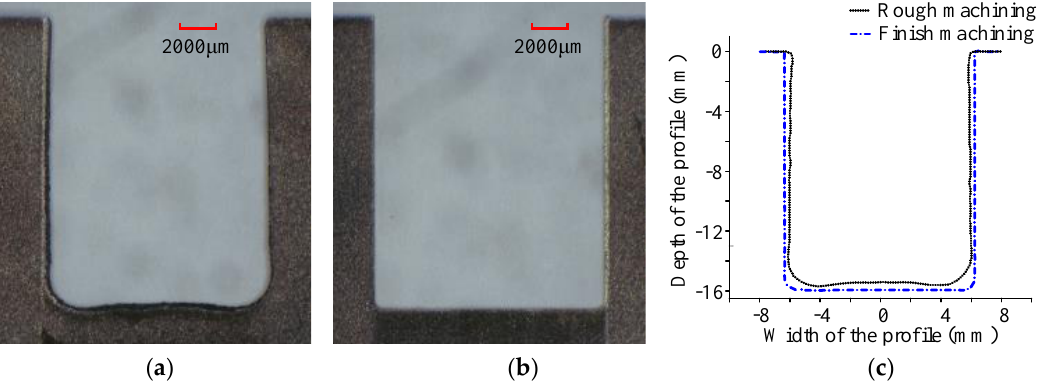
Figure 9. Cross-section profiles and measurement results of the grooves in the rough- and finish-